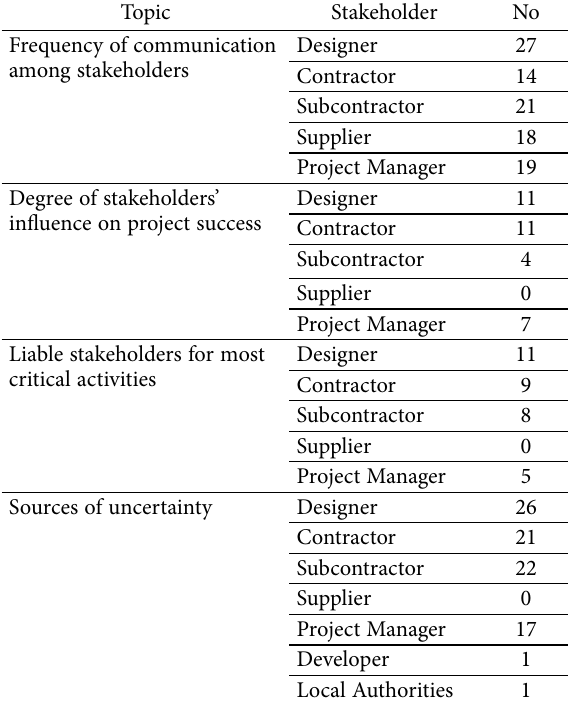
Table 1. Analysis results –